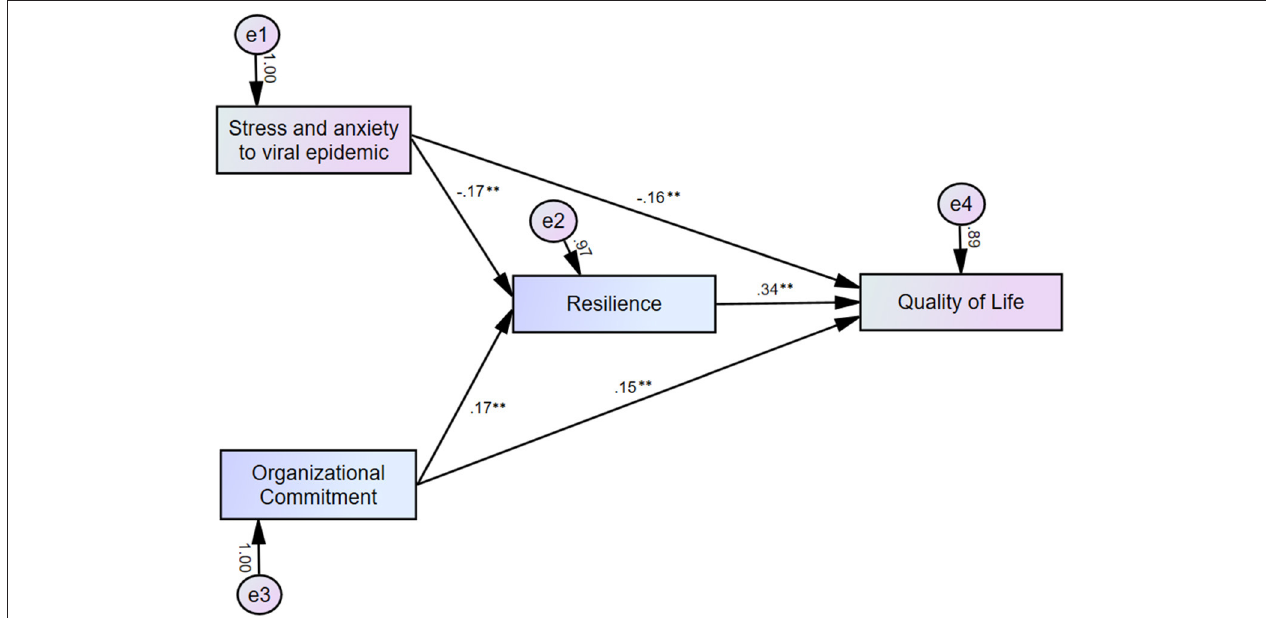
FIGURE 1 | Mediation model showing that the effect of organizational commitment and stress/anxiety in response to the viral epidemic (independent variable) on the quality of life (outcome) is mediated by resilience (mediator). ** p < 0.01.